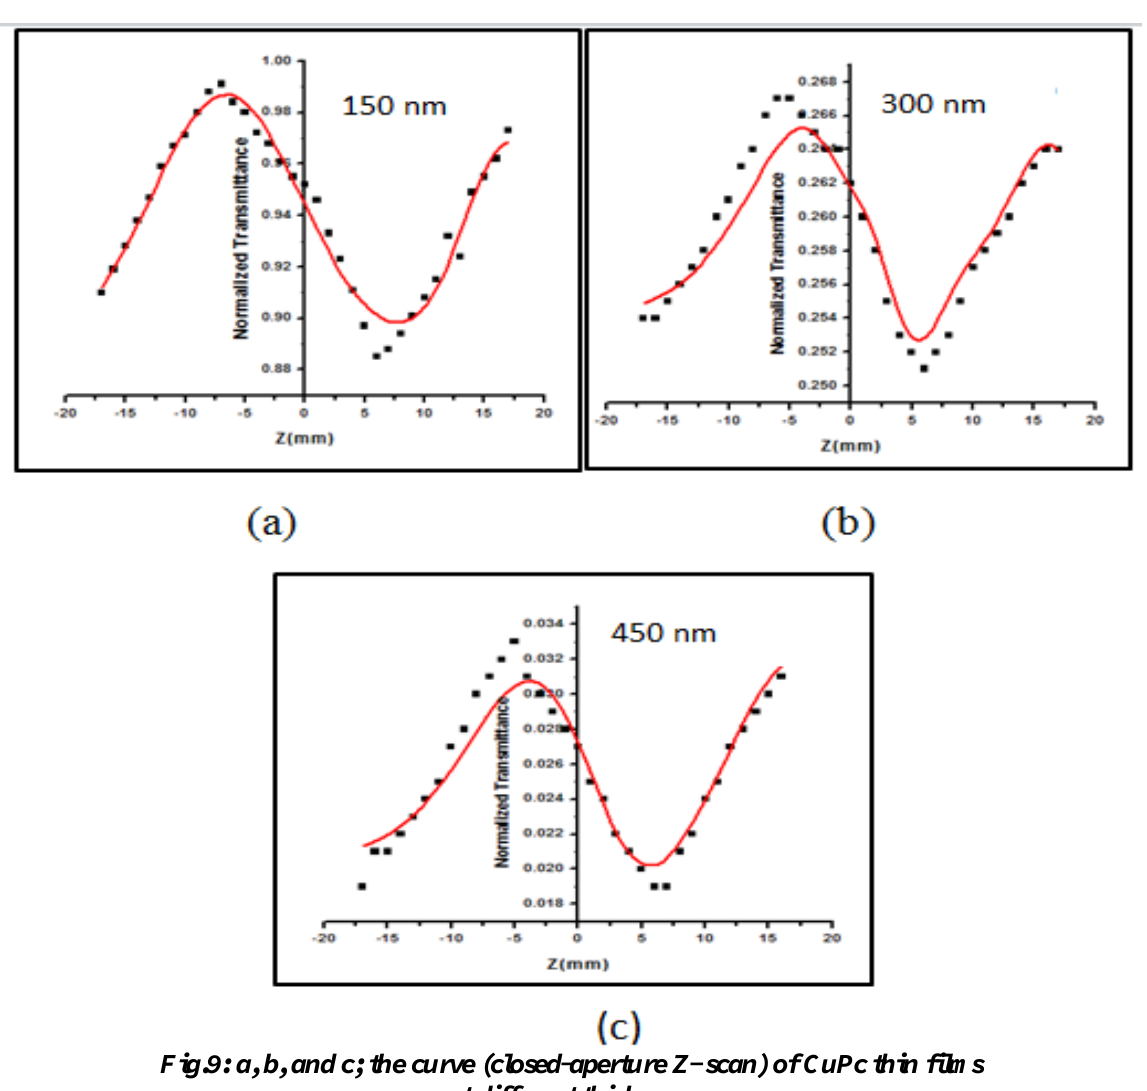
Fig.9: a, b, and c; the curve (closed-aperture Z- scan) of CuPc thin films at different